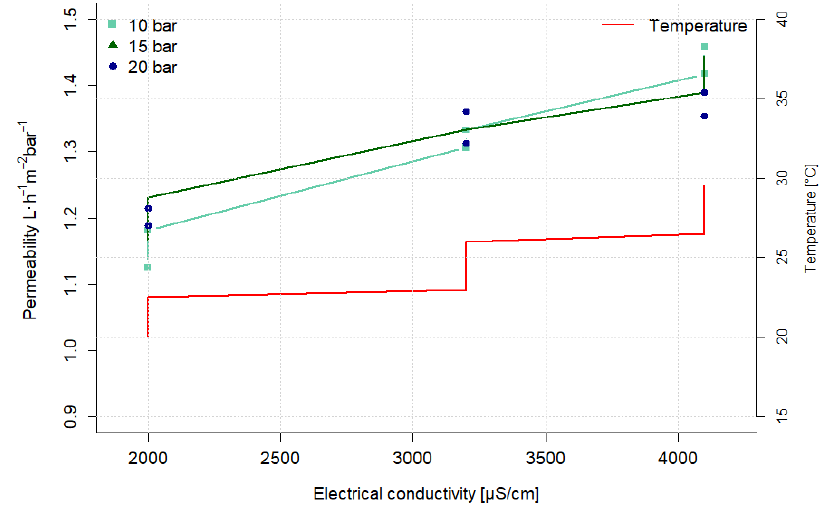
Figure 12. Permeability as a function of conductivity for reverse osmosis with BW30 membrane at different transmembrane pressures. Table 7. Rejection of the examined parameters by means of a BW30 spiral wound membrane module at 75%